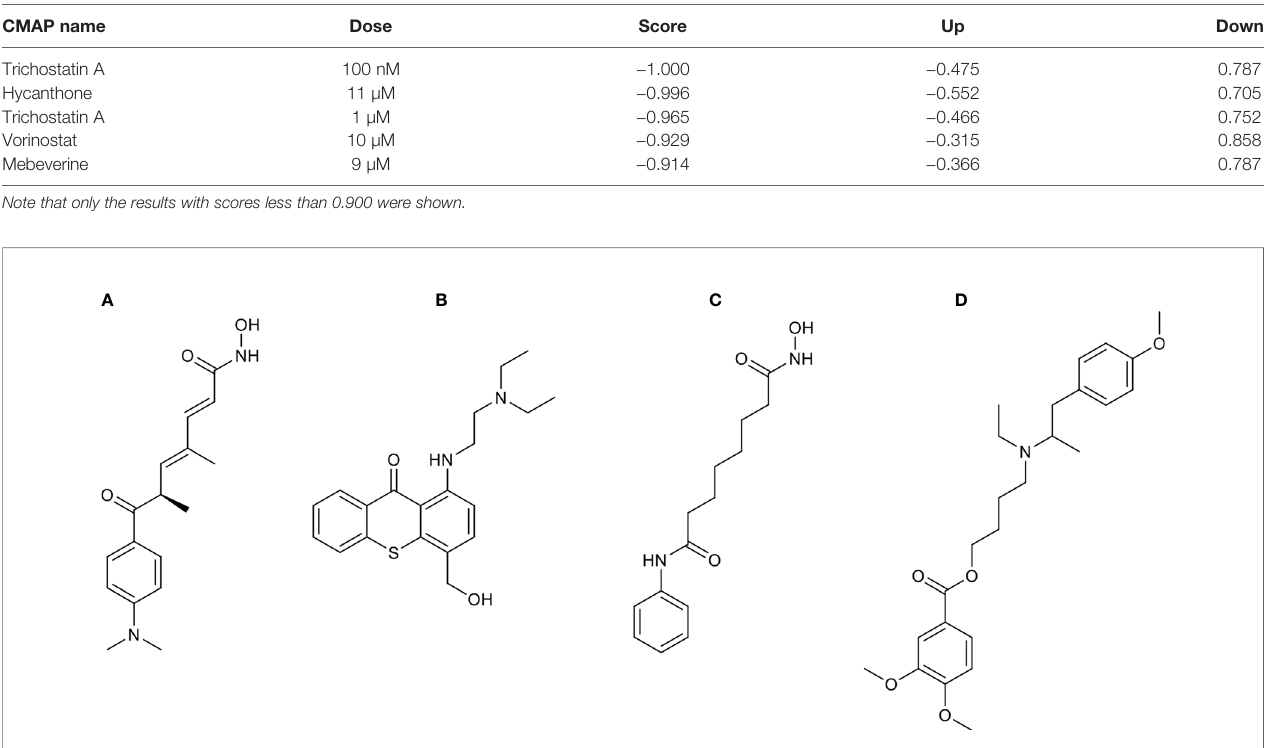
FIGURE 8 | The 2D structures of compounds identi fi ed by cMAP analysis. (A) Trichostatin A, (B) hycanthone, (C) vorinostat, and (D) mebeverine.